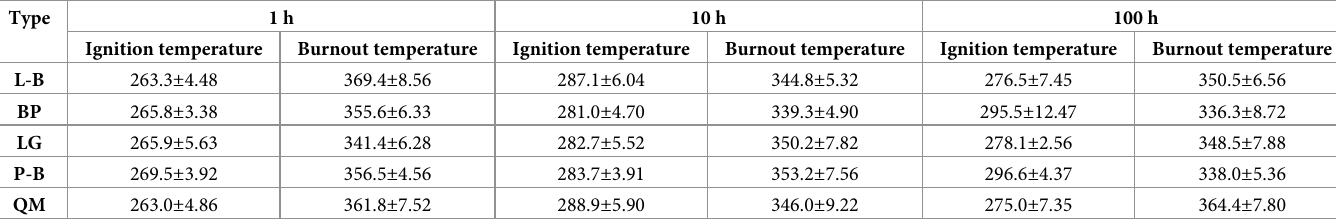
Table 5. Ignition and burnout temperatures (˚C) of combustible samples with different time